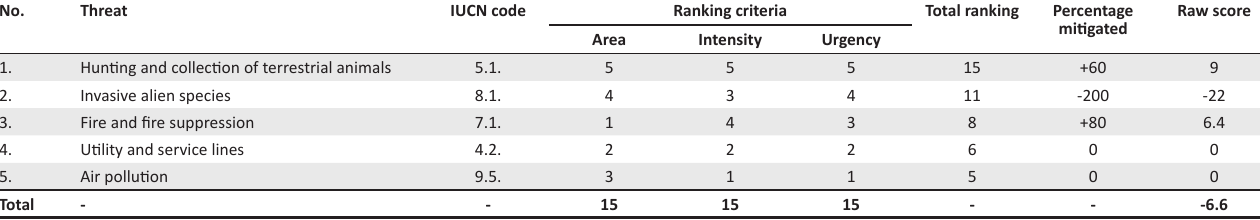
TABLE 3-A1: Threat reduction assessment index for Phalaborwa section of the Kruger National Park. No.